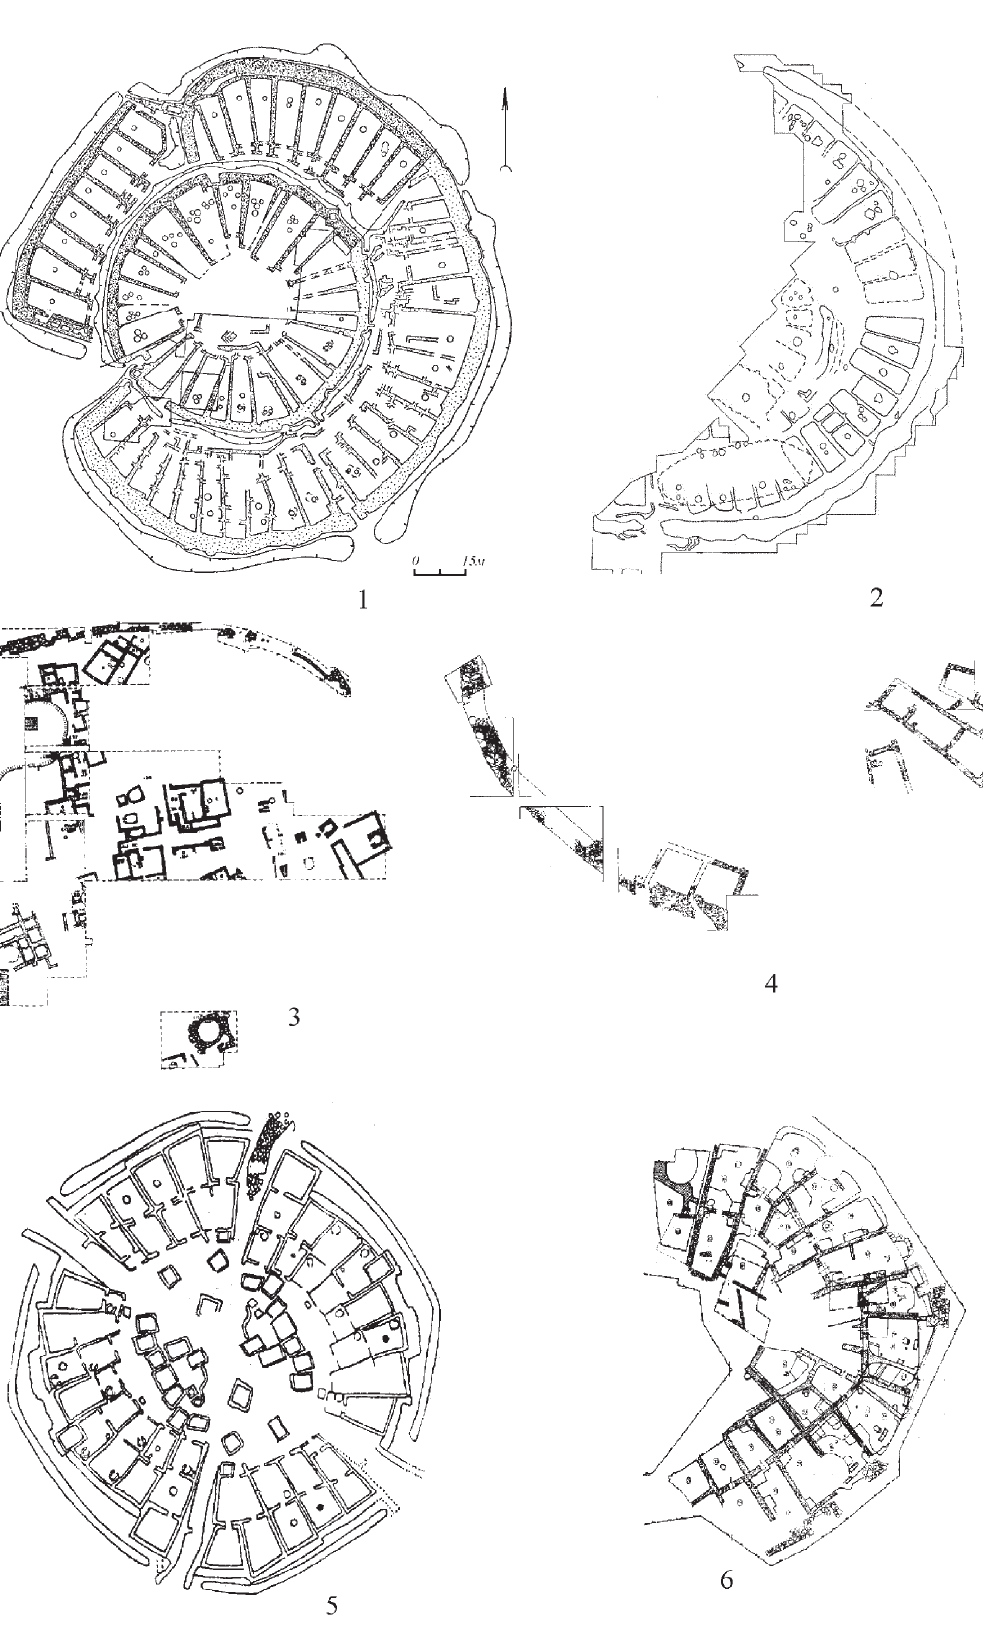
Figure 14: Sintashta fortified settlements (1, 2) and their analogues in Anatolia (3–6): 1 – Arkaim, 2 – Sintashta, 3 – Tüllintepe; 4 – Heraion; 5 – Demircihöyük; 6 – Pulur (1 – after Zdanovich, 1997; 2 – after Gening, Zdanovich, & Gening, 1992; 3–6 – after Korfmann, 1983; Grigoriev,